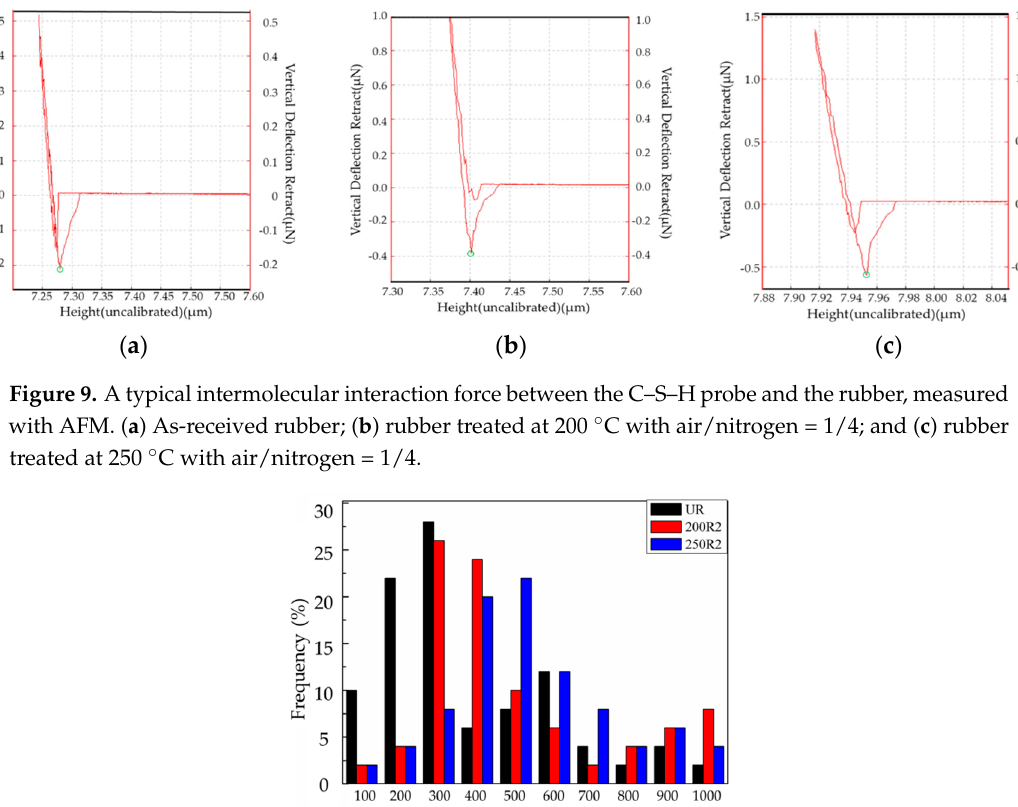
Figure 10. The intermolecular interaction forces between the C–S–H probe and rubber: as-received ( black ); treated at 200 °C with air/nitrogen = 1/4 ( red ); treated at 250 °C with air/nitrogen = 1/4 ( blue ).